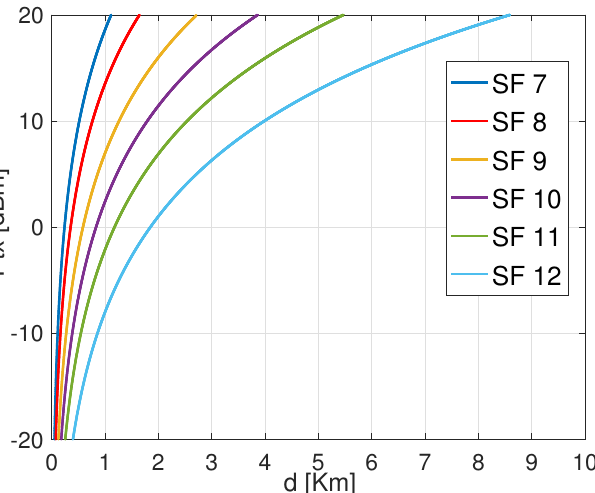
d for different SFs with CR 4/7 to carry out tx versus range